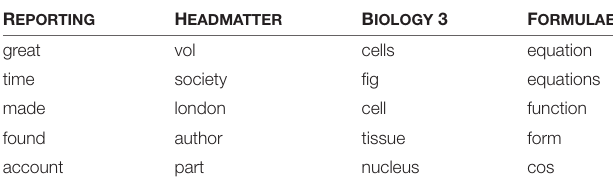
explore the systematic association of words with discourse fields. TABLE 2 | Top five words for selected